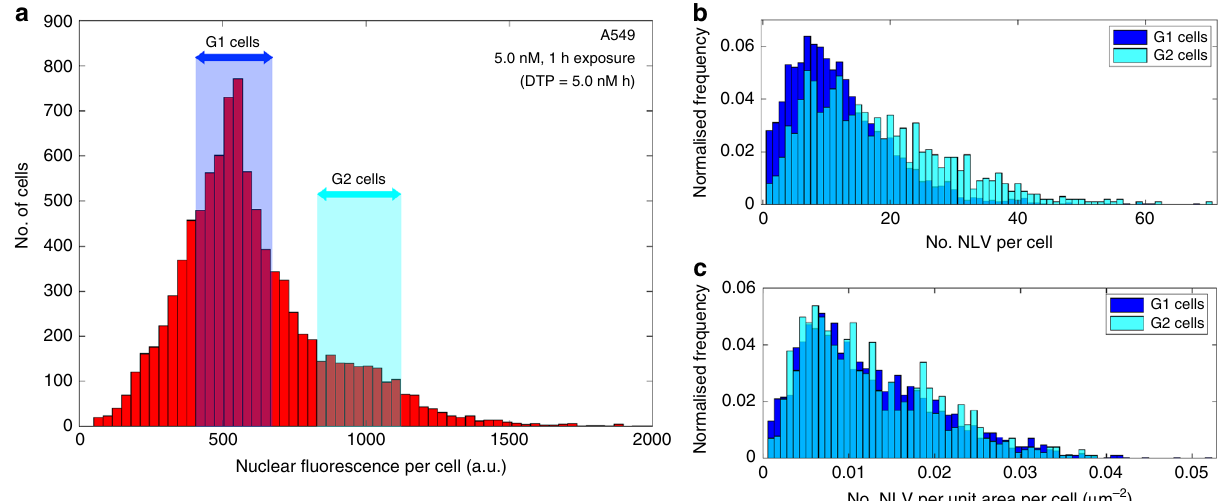
Fig. 4 The role of cell cycle position on nanoparticle uptake. a A typical per-cell nuclear intensity (Hoechst 33342) histogram showing gating of cells within the characteristic G1 or G2 cell cycle positions. b Histograms showing the distributions of the number of NLVs per cell for the cell populations selected by the G1 or G2 cell cycle gates shown in a . An increase in the average number of NLVs per cell is apparent for the G2 cell population, and a two-sample Kolmogorov – Smirnov (KS) test rejects the null hypothesis at the 5% signi fi cance level that the two distributions are the same ( p = 7.447 × 10 − 35 , two- sample Kolmogorov – Smirnov stat = 0.229). c Replotted histograms of the data shown in b , with the number of NLVs per cell normalised against each cell ’ s area. The two distributions now appear identical, and the null hypothesis that the two distributions are the same is not rejected even at the 0.1% signi fi cance level ( p = 0.586, two-sample Kolmogorov – Smirnov stat = 0.028). Rather than cell-cycle-dependent uptake rates, cells at G2 present a larger area with which to capture arriving nanoparticles. The underlying data are provided in the BioStudies database under the accession code